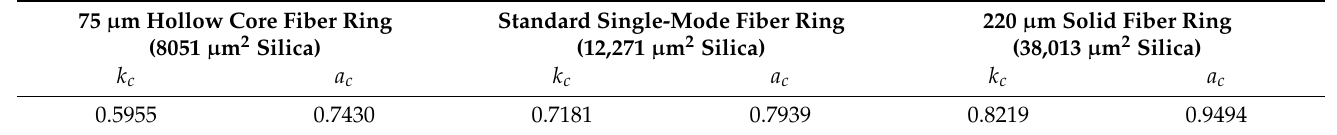
Table 1. Empirical k c and a c for a 75- µ m hollow-core fiber ring, a standard single-mode fiber ring, and a 220- µ m solid fiber